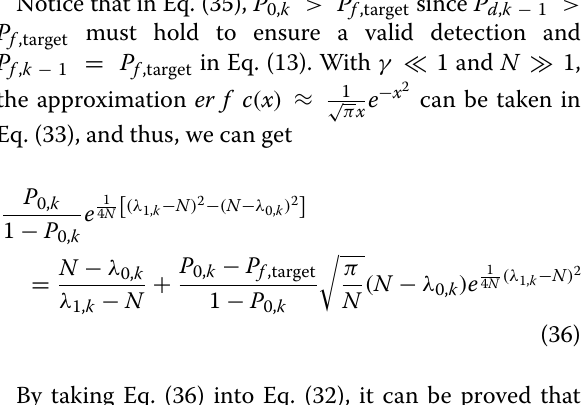
Figure 4 verifies the double thresholds of the IF-DDT algorithm changing with the frame index k . Figure